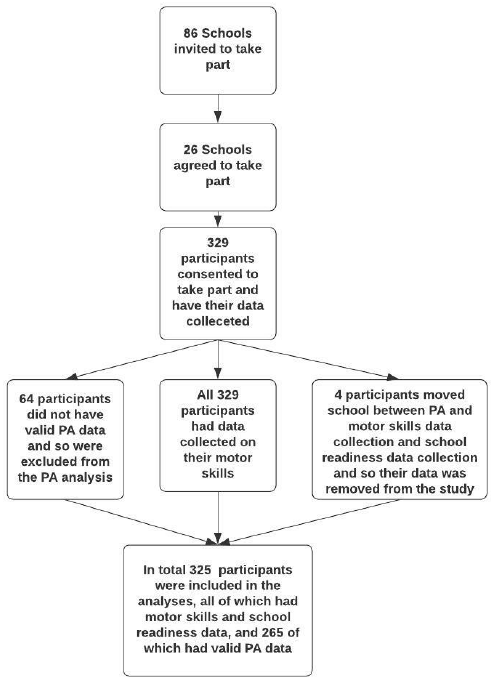
Figure 1. Flowchart showing data-collection and analysis procedure.